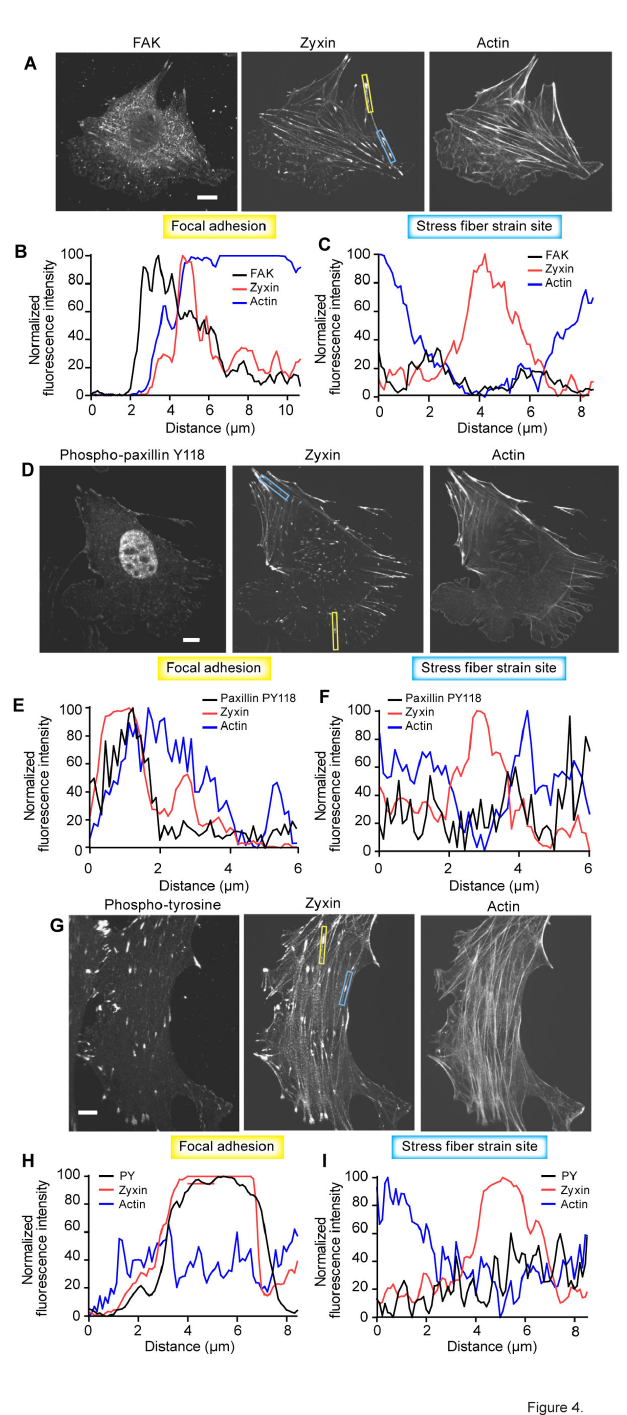
Figure 4. Paxillin does not stabilize stress fiber strain sites through integrin signaling. Micrographs of fixed fibroblasts labeled for paxillin interacting protein FAK in conjunction zyxin-GFP, and Lifeact-mApple (A), and linescans through either a focal adhesion (B), or stress fiber strain site (C). FAK is present in focal adhesions, but is not found at stress fiber strain sites while zyxin localizes to both sites. Micrographs of fixed fibroblasts labeled for phospo-paxillin Y118 in conjunction zyxin-GFP, and Lifeact- mApple (D). Phospho-paxillin Y118 labels focal adhesions (E) but not strain sites (F). Similarly, phospho-tyrosine immunolocalization in conjunction zyxin-GFP, and Lifeact-mApple (G) detected phopho-tyrosine activation at focal adhesions (H), but not at strain sites (I). Scale bar=10um. doi: 10.1371/journal.pone.0069378.g004 PLOS ONE |